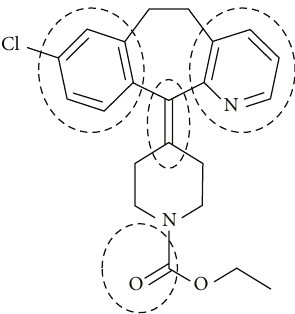
Figure 1: Chemical structure of loratadine. The chemical groups susceptible to light degradation are